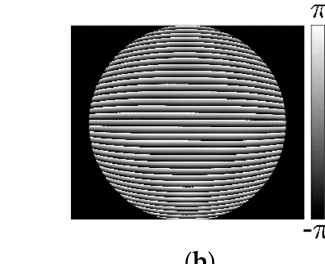
( b ) Figure 11. Intensity distribution of the distorted fringe-patters. ( a ) Intensity of the central row of the longitudinal fringe- pattern with a phase shift of / 2 π ; ( b ) Intensity of the central column of the transverse fringe-pattern with a phase shift of / 2 π